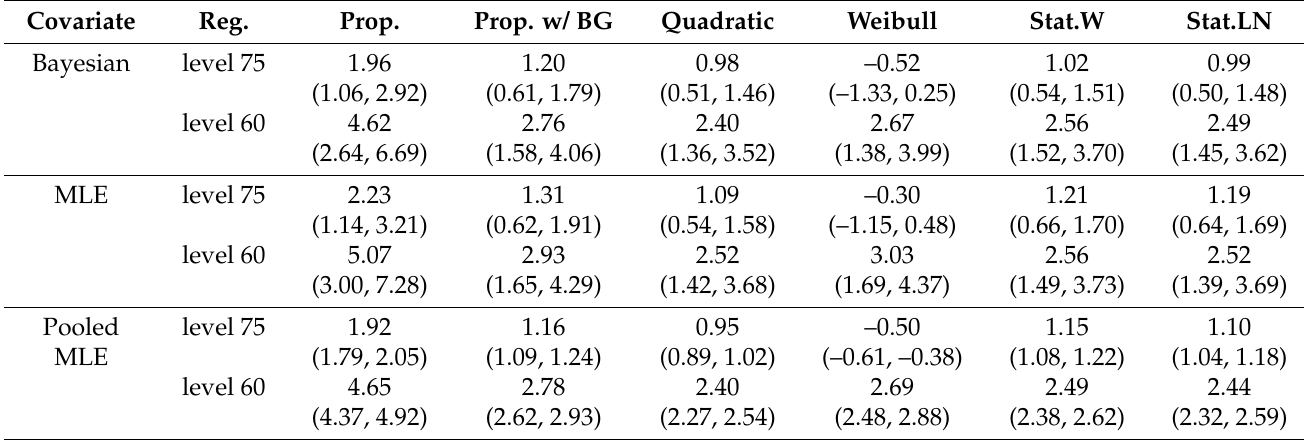
Table 4. Posterior means and 95% confidence intervals of total mortality reduction per 1000 deaths (1998–2000): city-specific rollback and CDL model.